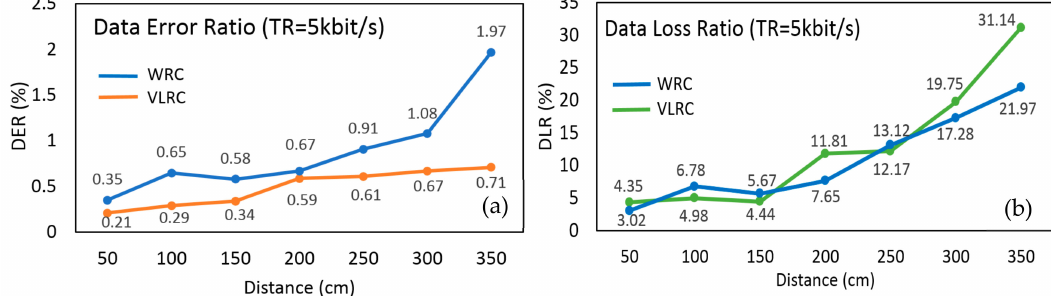
Figure 11. ( a ) Data error ratio (DER) and ( b ) Data loss ratio (DLR) test at di ff erent